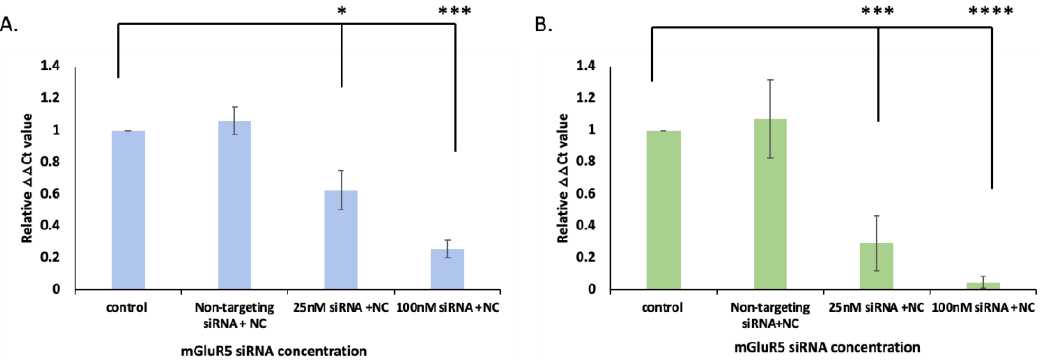
Figure 3. Quantitative RT-PCR was performed to detect the mGluR5 expression in ( A ) LM7 human metastatic osteosarcoma cells and ( B ) OS482 mouse metastatic osteosarcoma cells. When 100 nM mGluR5 siRNAs were loaded to IO-nanocages and delivered in both LM7 and OS482 cells, the mGluR5 expression was reduced significantly. The AMFs application was performed at 445 kHz. * p < 0.05, *** p < 0.001, **** p < 0.0001, N = 4.